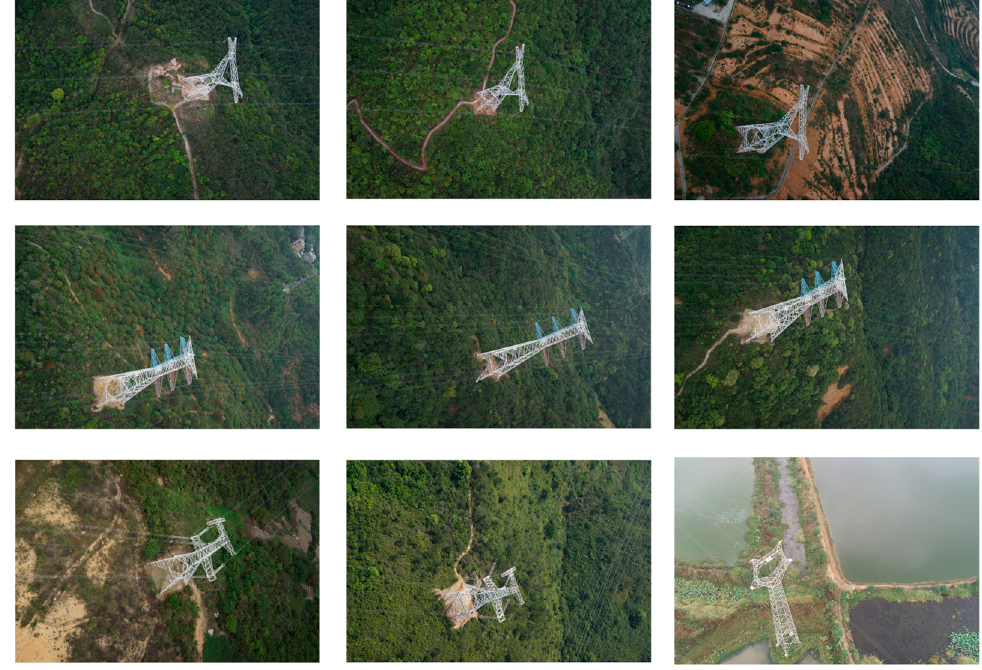
Figure 10. The images of pylon.